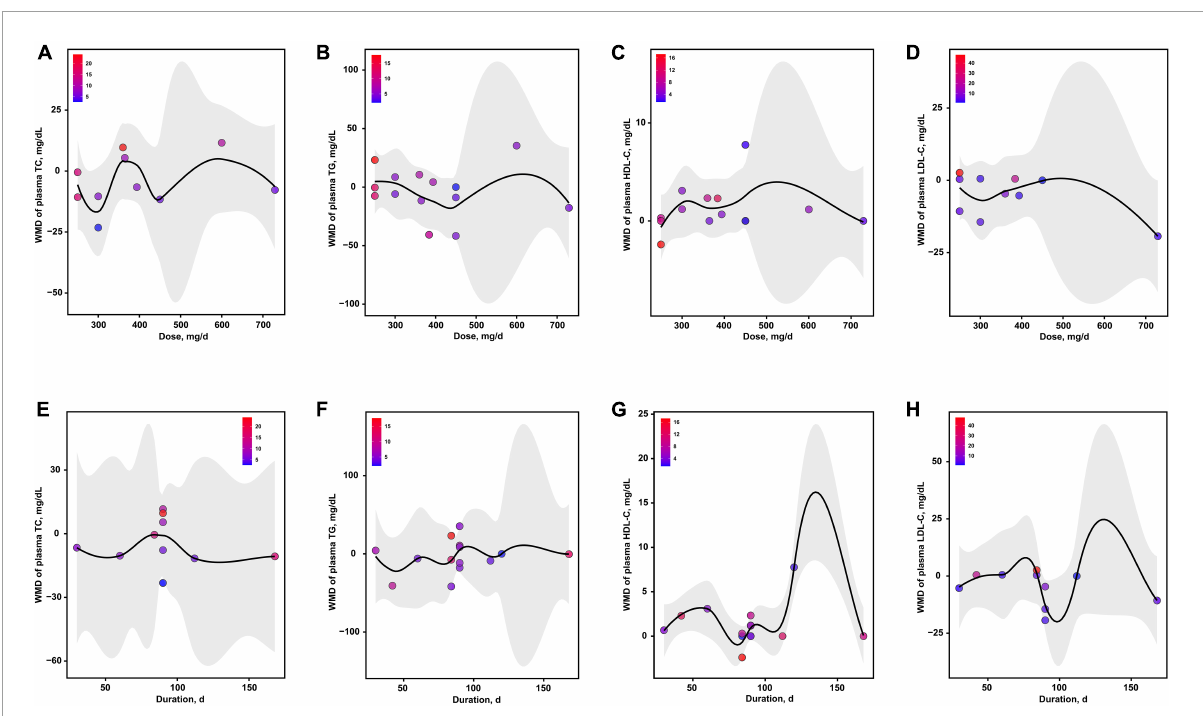
FIGURE6 The effects of dosage or duration of magnesium intervention on lipid metabolism for TC (A,E) , TG (B,F) , HDL-C (C,G) , and LDL-C (D,H) , respectively. HDL-C, high-density lipoprotein cholesterol; LDL-C, low-density lipoprotein cholesterol; TC, total cholesterol; TG, total